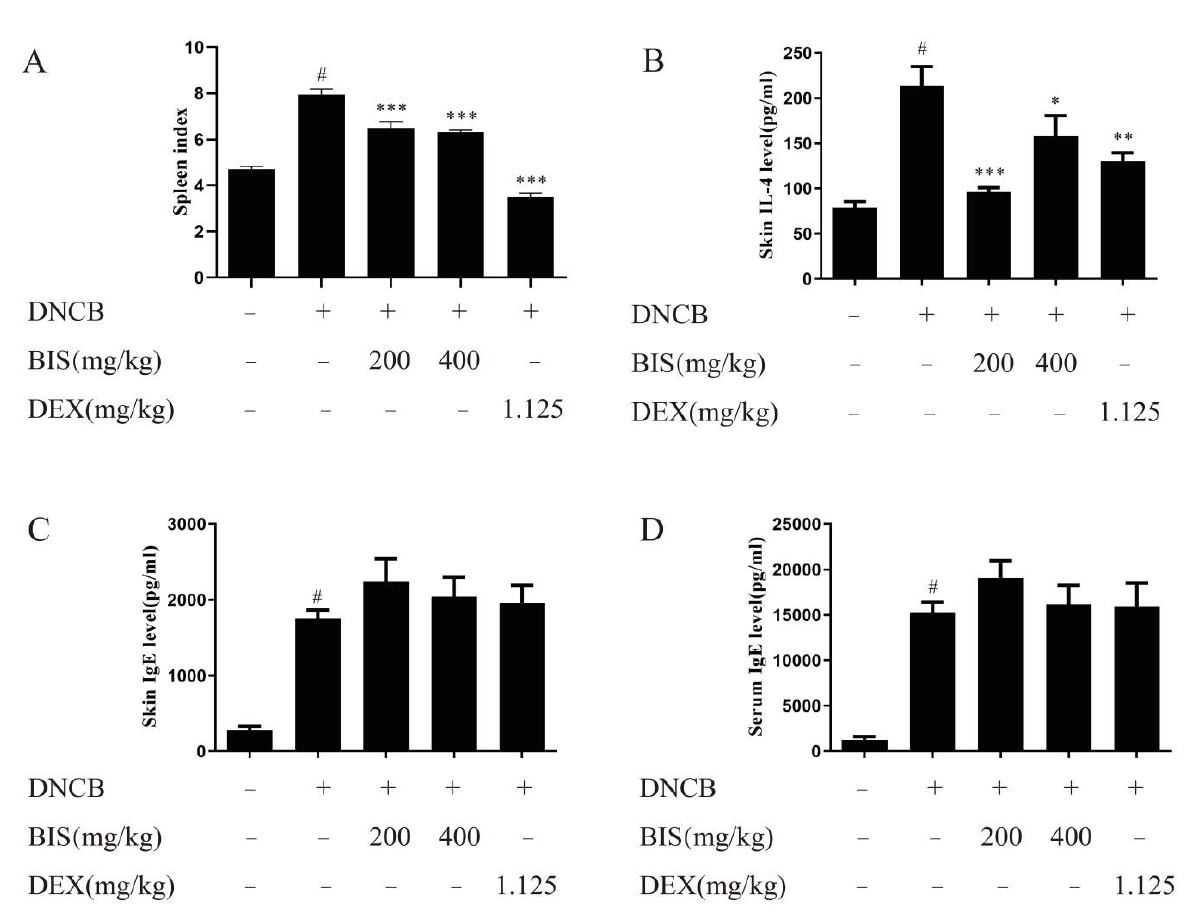
Figure 3. BIS relieved abnormal immune response in AD-like mice. ( A ) Measurement of spleen index by calculating spleen weight/body weight. Skin levels of IL-4 ( B ), skin levels of IgE ( C ) and serum levels of IgE ( D ) were measured by ELISA. Data represent the mean ± SEM, n ≥ 8 mice/group. # p < 0.05 vs. Control; * p < 0.05, ** p < 0.01, *** p < 0.001 vs. Model.